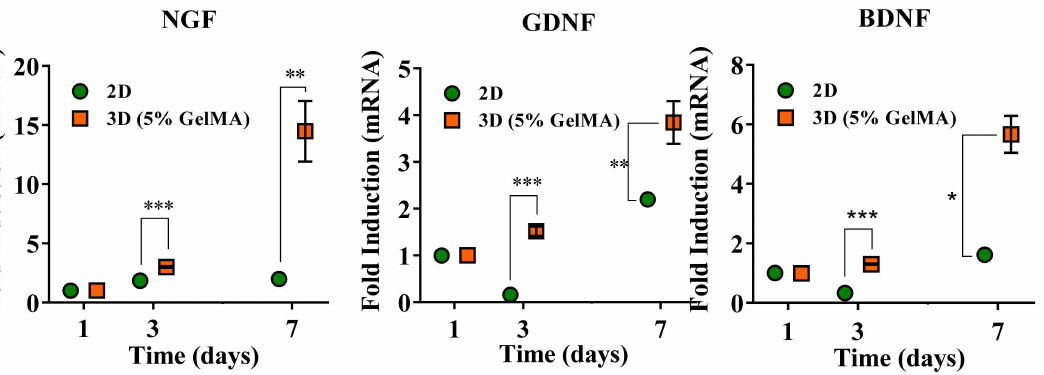
Figure 6. qPCR result of neurotrophic factors expression in 2D and 3D models. * p < 0.05, ** < 0.01, *** p <